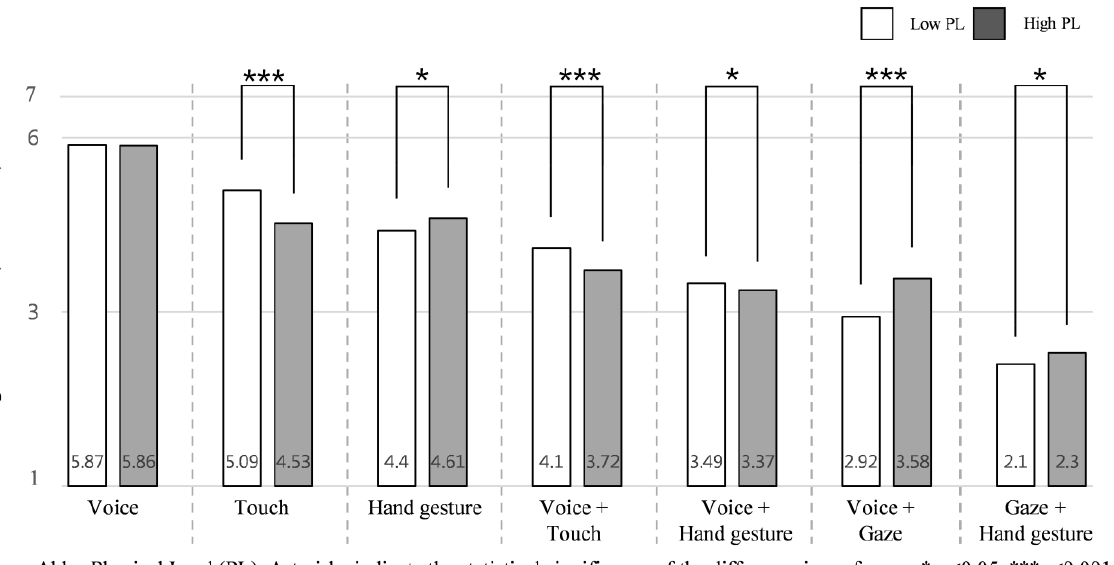
Figure 9. Average preference for the seven input interactions according to physical load of NDRTs: low physical load vs. high physical load.